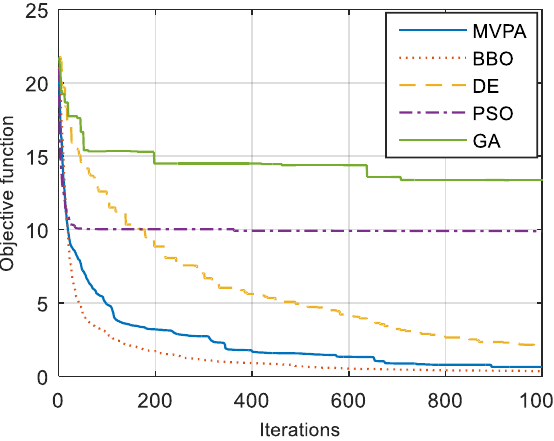
Figure 9. Evolution of the objective function versus iterations for case 4.